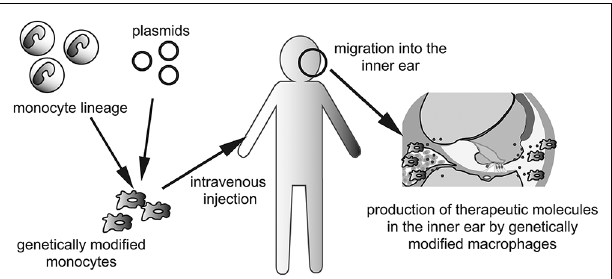
FIGURE 2 | Schematic depictions of a concept to utilize genetically modified macrophages for the treatment of inner ear diseases. Autologous monocyte lineage is taken from patient’s peripheral blood, and transfected plasmids of targeted gene. After ex vivo culturing, genetically modified monocytes are injected intravenously. Injected monocytes are migrating into the inner ear to differentiate to tissue macrophages. Genetically modified macrophages produce and secrete therapeutic molecules which diffuse throughout the fluid of the inner ear.